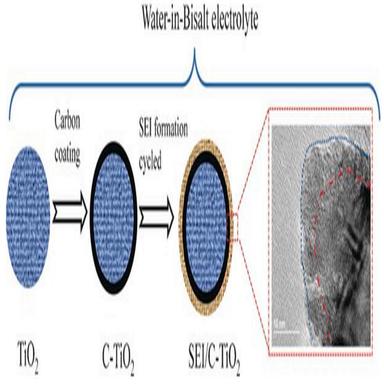
Post-mortem analysis on the cycled anatase C/TiO2 in water-in-bisalt electrolyte. Reproduced with permission from Wiley.